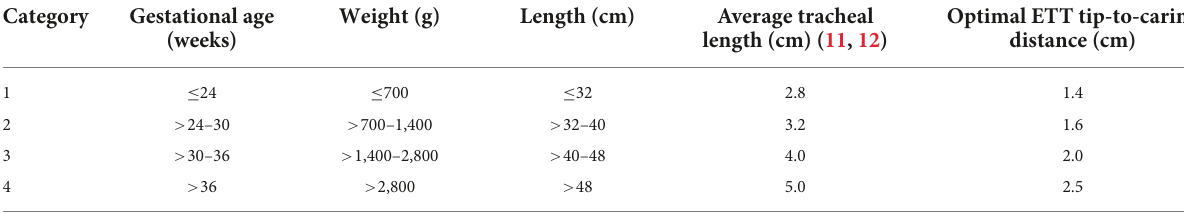
TABLE 1 Gestational age-, weight-, and length-based categories with the corresponding optimal ETT tip-to-carina